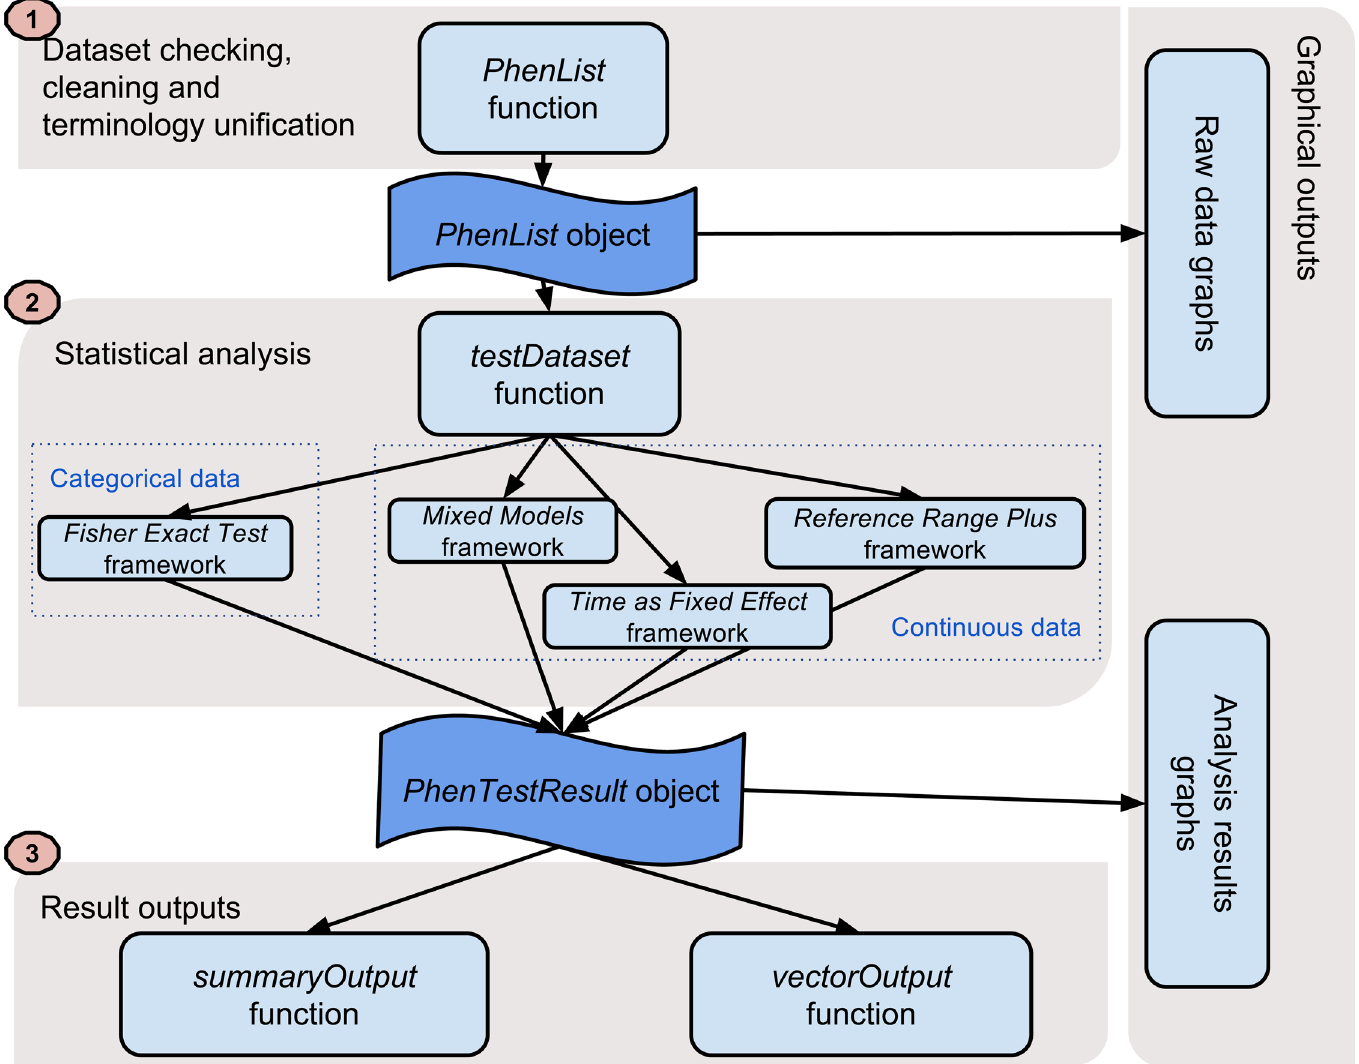
Fig 1. The PhenStat package's three-layer structure. The PhenStat package is designed with a three layer structure: dataset processing, analysis and result. In addition, there is a layer with graphical